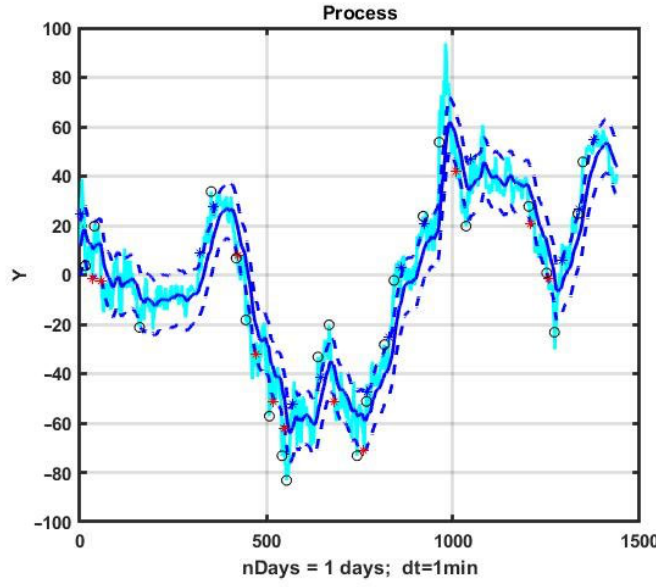
Figure 3. Example implementation of CSF with optimized parameters.